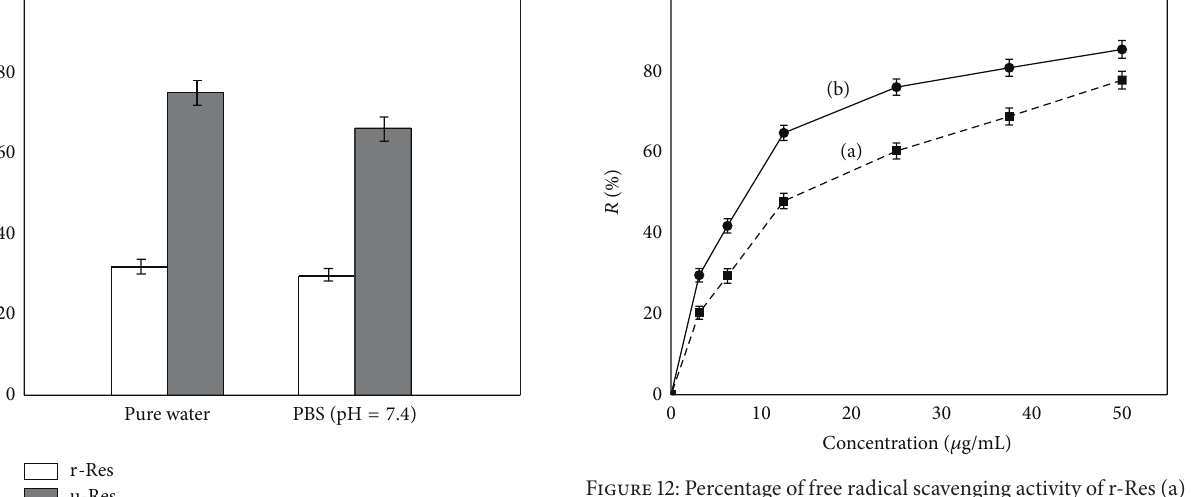
Figure 12: Percentage of free radical scavenging activity of r-Res (a) and u-Res (b).